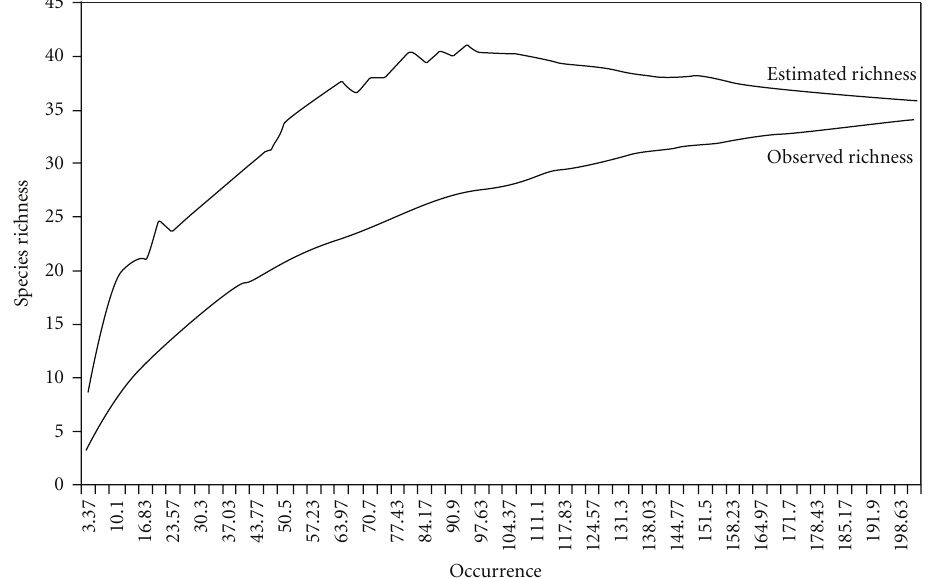
Figure 1: Accumulation and estimated species richness curves in undecomposed twigs in the leaf litter of dense ombrophilous